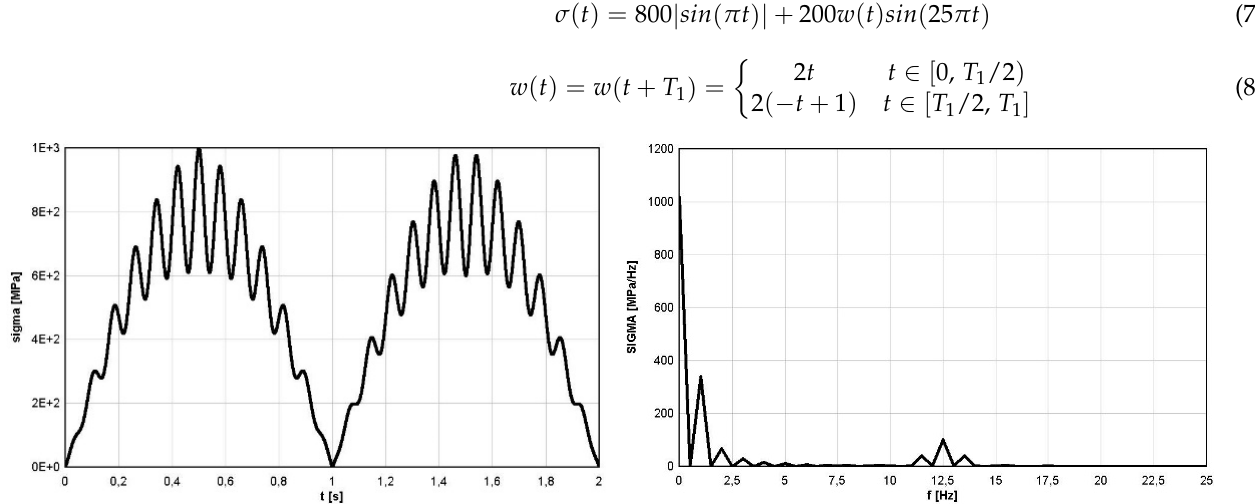
Figure 5. Time history of the function (9) ( left ) and its FFT form ( right ).